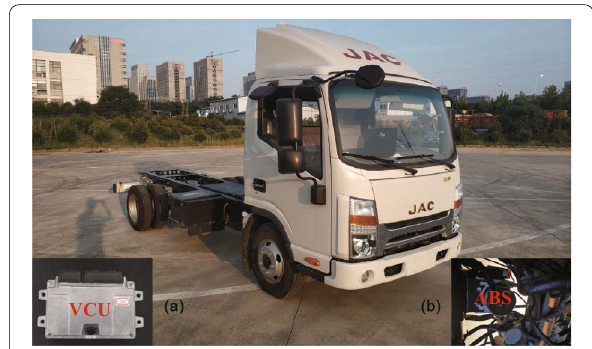
Figure 6 Test platform of battery electric vehicle